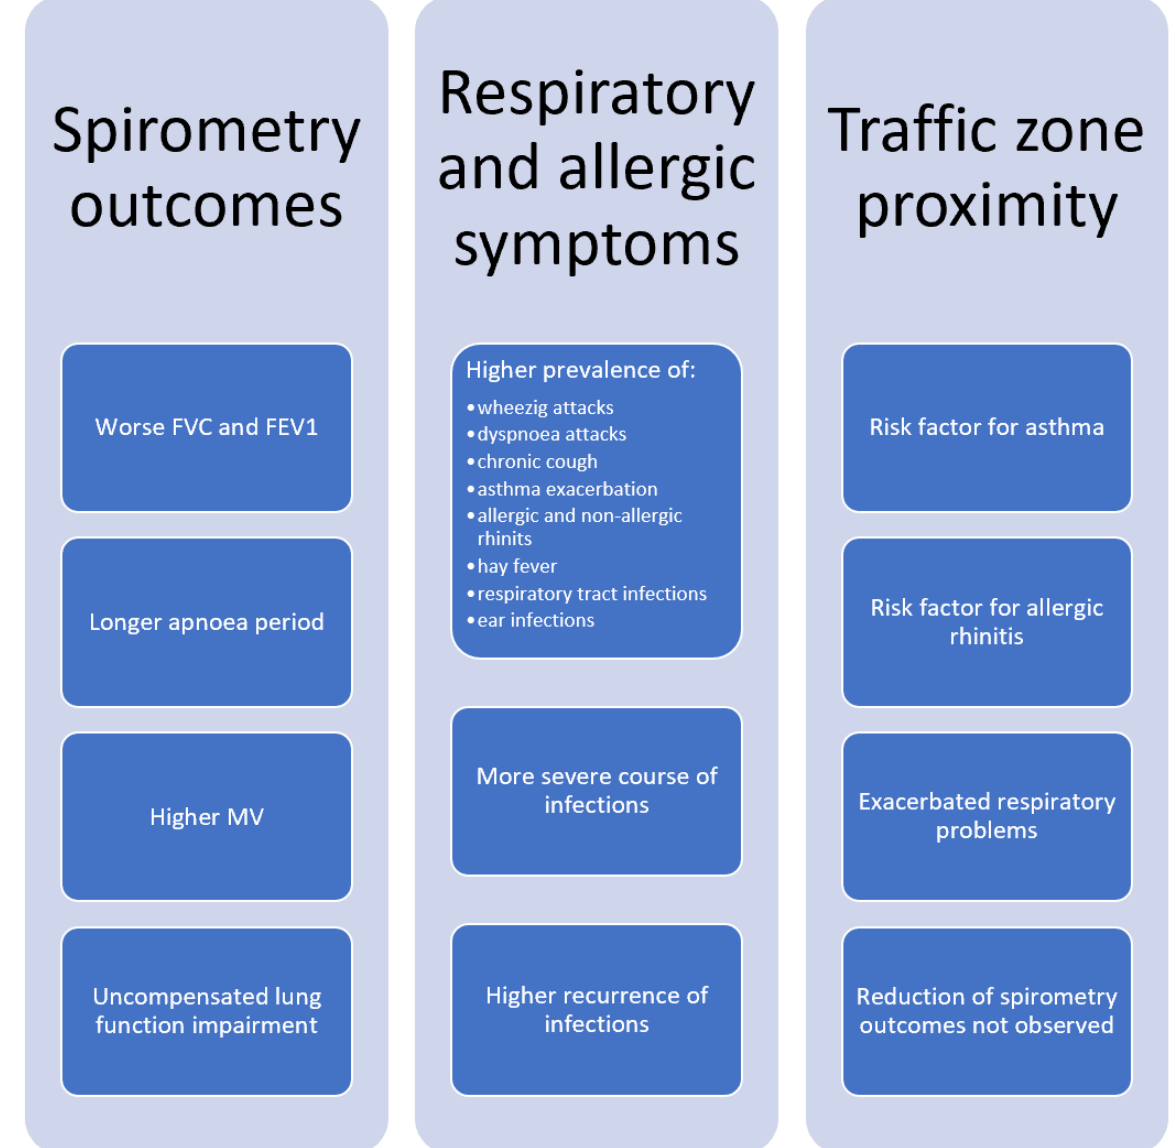
Figure 5. Effect of air pollution on children’s health.